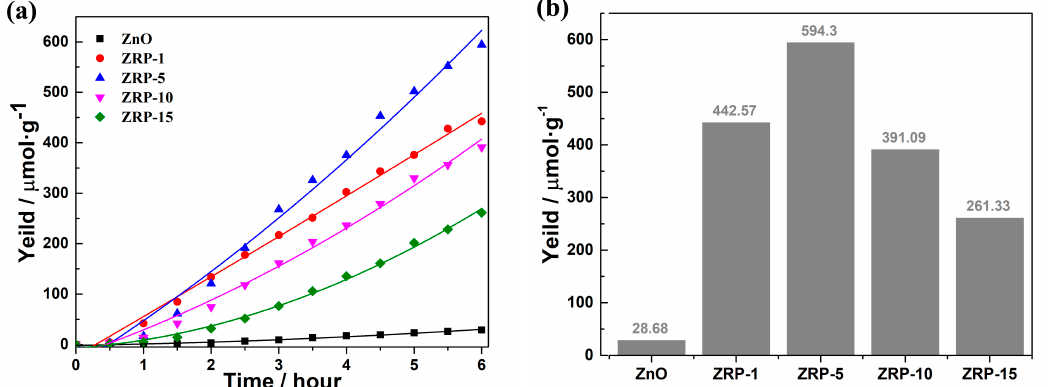
Figure 4. ( a ) Photocatalytic H 2 evolution of the as-synthesized heterojunctions under AM 1.5 irradiation; ( b ) Photocatalytic H 2 release yield in 6 h.